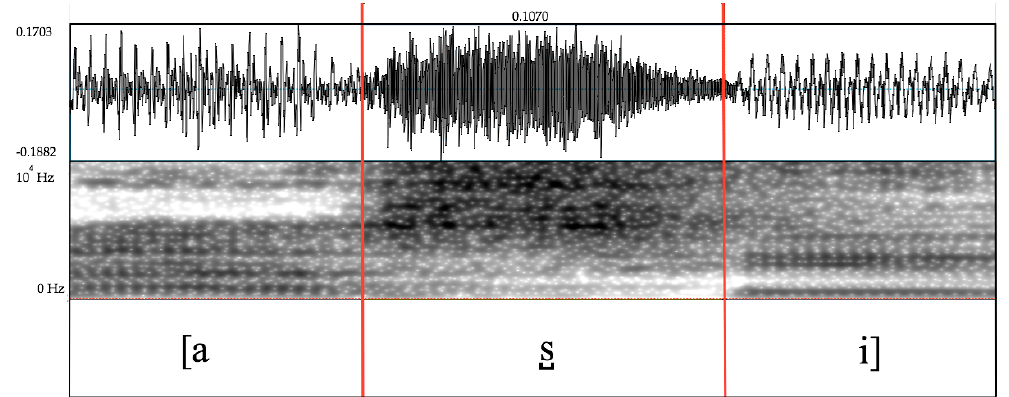
Figure 2. Waveform and spectrogram of the sibilant in the word hasi ‘begin’. Languages 2017 , 2 , 25